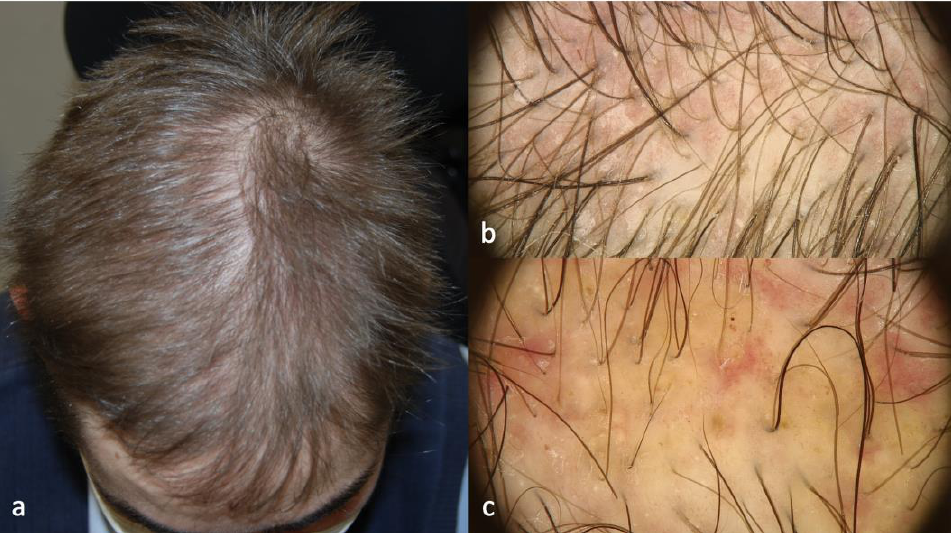
Figure 7. Clinical ( a ) and trichoscopic findings of Patient 5 and ( b , c ) magnification 20×.